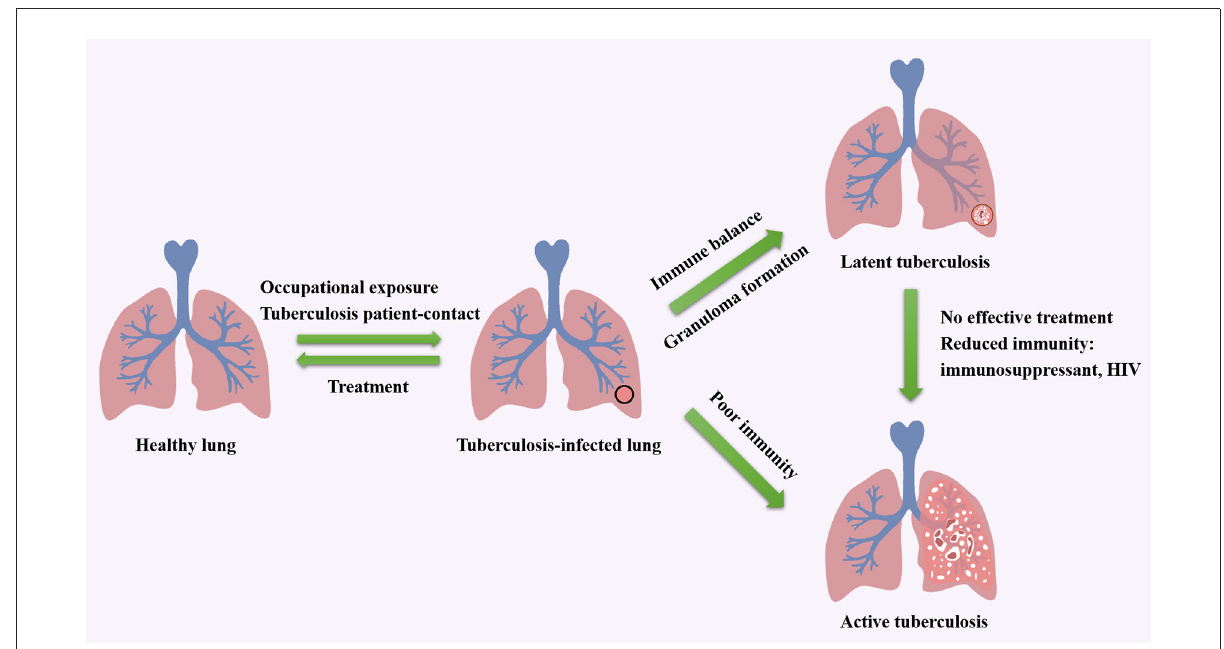
FIGURE1 The cycle of tuberculosis infection and the factors that impact the development of